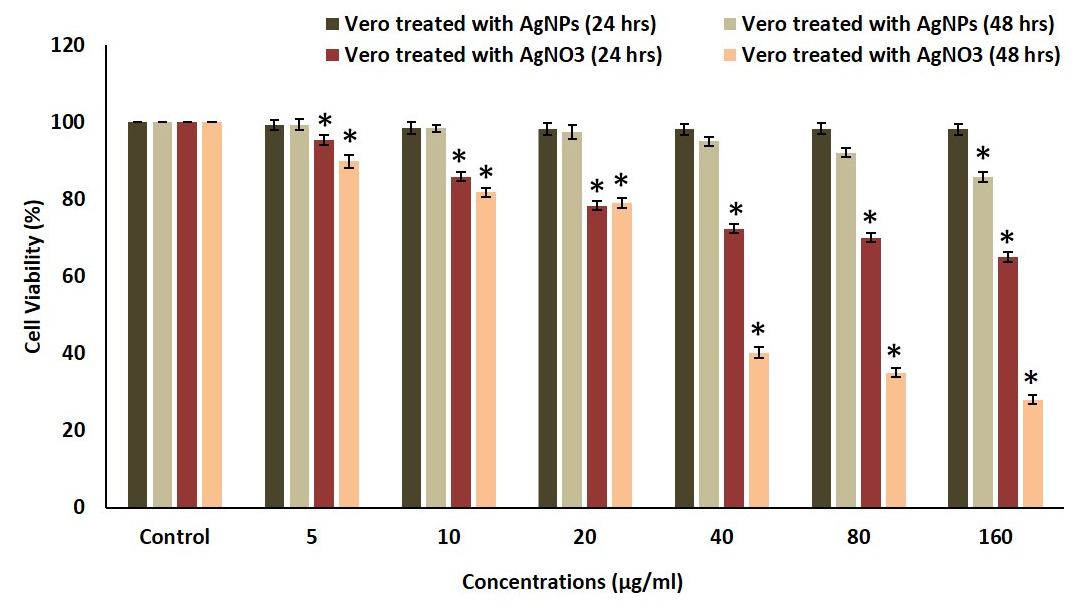
Figure 8. Effect of AgNO 3 and Asf-AgNPs on normal Vero cells at 24 and 48 hrs. Values are given as mean ± S.D. for each concentration. *Indicates the treated concentrations statistically significant ( p < 0.05) when compared to control.